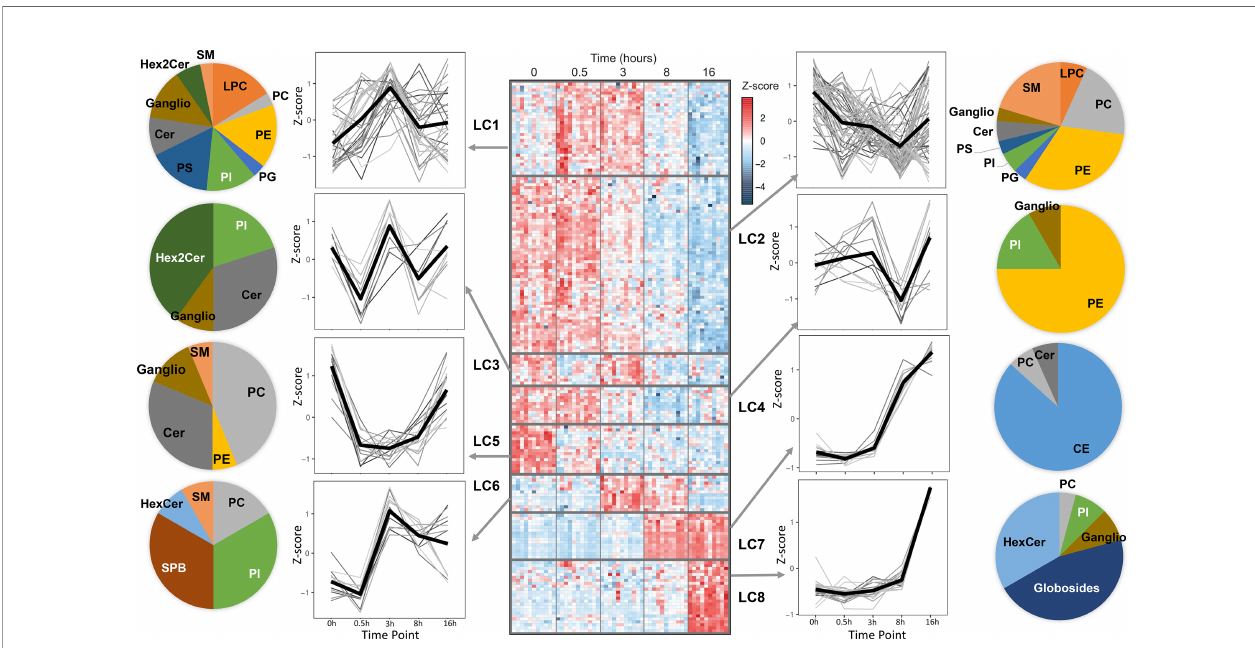
FIGURE 1 | Temporal lipidomics analysis in human macrophages reveal LPS-dependent lipid kinetics. Heatmap showing 179 lipids with signi fi cant changes across time (FDR <0.05) are distributed among 8 lipid clusters (LC). Each cluster is separated by horizontal lines. At least N=10 donors were used and hMDMs were used as untreated or LPS-stimulated for 30 min, 3h, 8h and 16h (see Methods for cluster generation). In the heatmap, each row depicts the relative abundance of a single lipid and data are presented following z-score transformation. See also Supplementary Table 1 for details of the lipids included in each time series cluster. The kinetic trends of each LC and the lipid species are represented as line plots and pie charts, respectively. PC, phosphatidylcholines; PE, phosphatidylethanolamines; PI, phosphatidylinositol; PG, phosphatidylglycerols; PS, phosphatidylserine; LPC, lysophosphatidylcholine; Cer, ceramides; SM, sphingomyelins; HexCer, monohexosylceramides; Hex2Cer, dihexosylceramides; CE, cholesteryl esters; Ganglio, gangliosides; SPB, sphingoid